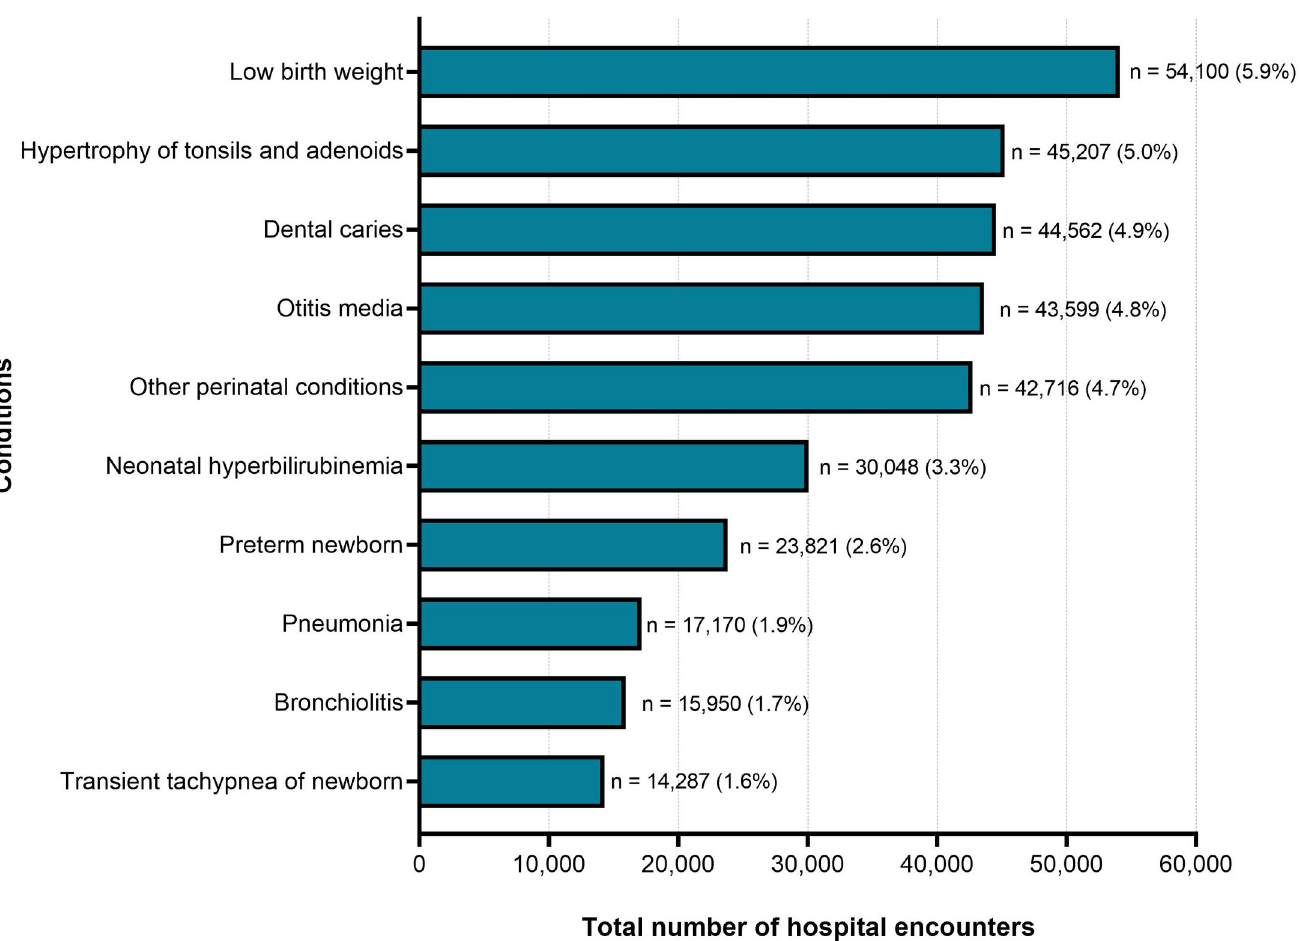
Fig 3. Top 10 most prevalent conditions identified by applying PECCS-CA to administrative data of pediatric hospital encounters in Ontario, 2014–2019. This figure focuses on the 10 most prevalent conditions in children with hospital encounters in Ontario during 2014–2019. Data for pediatric hospital encounters (inpatient discharges, same day surgery) were obtained from the Canadian Institute for Health Information Discharge Abstract Database (CIHI-DAD) and Same Day Surgery (SDS) database. (n = total number of hospital encounters for the condition; % = percentage of hospital encounters for the condition from all hospital encounters. The percentages displayed do not equal to 100%, because only the top 10 most prevalent conditions are presented).